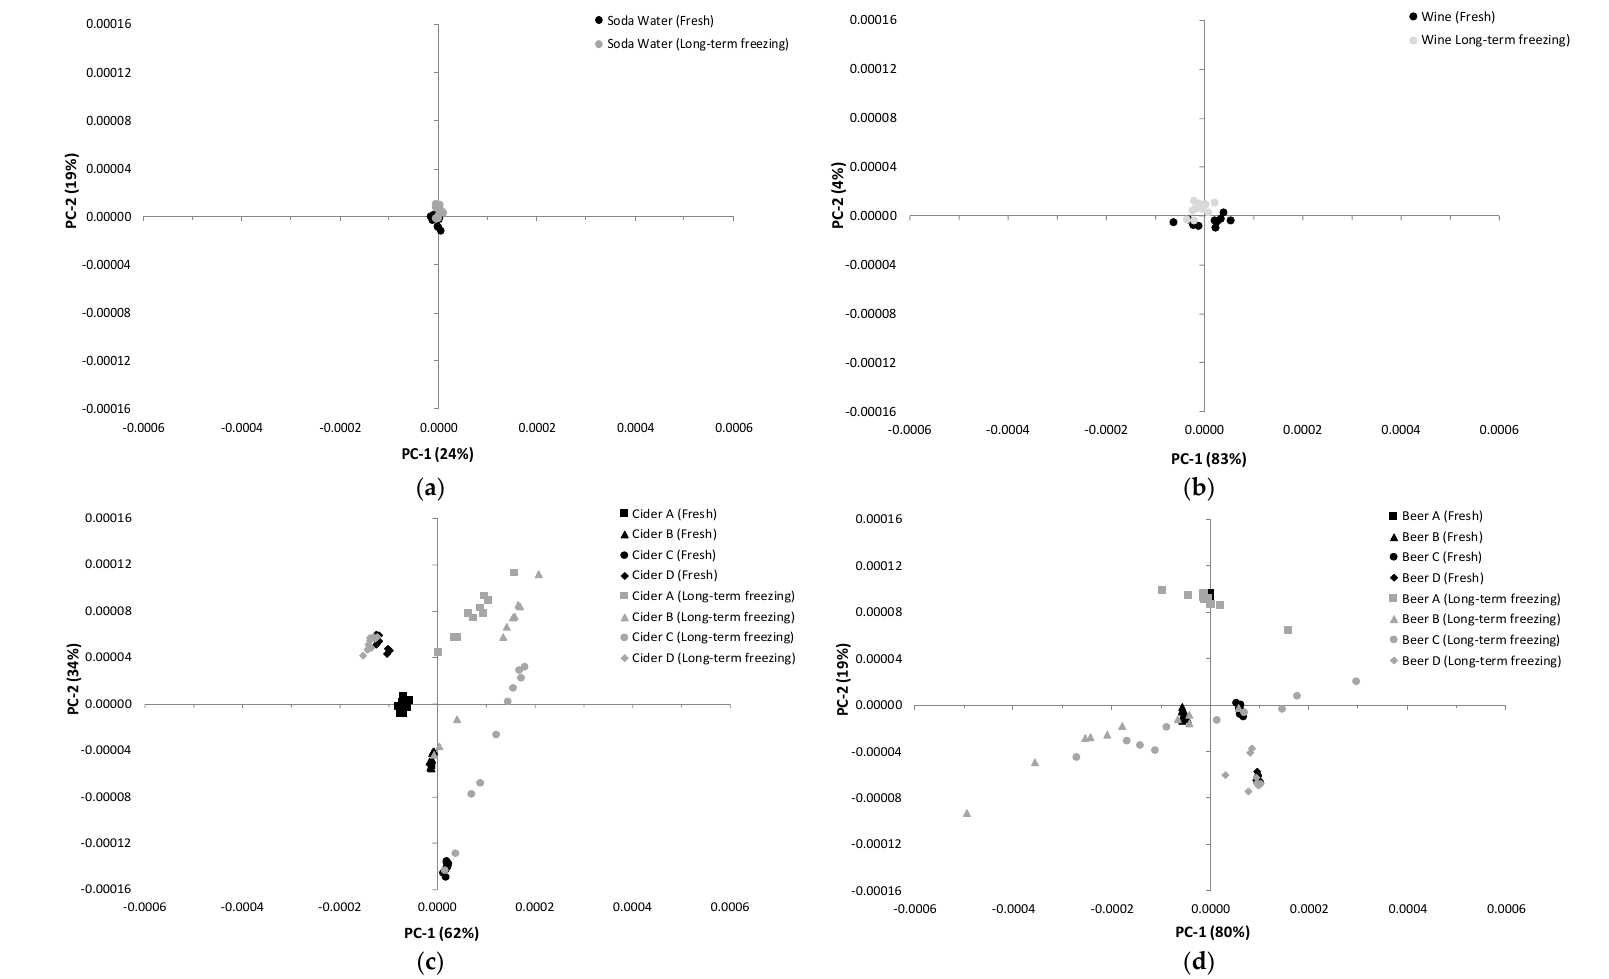
Figure 3. Score plots of the first two PCs derived from the MIR fingerprint region (1500–900 cm − 1 ) of ( a ) sparkling water; ( b ) sparkling wine; ( c ) ciders; and ( d ) beers prior to storage (i.e., fresh and degassed) and following long ‐ term (6 week) freezing.